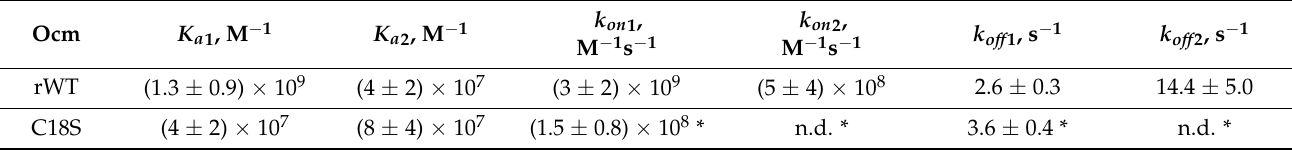
Table 5. Equilibrium and kinetic parameters of Ca 2+ binding to rWT/C18S Ocm at 20 ◦ C, estimated from the fluorimetric experiments. The values of equilibrium metal association constants, K a 1 and K a 2 , and rate constants of metal dissociation, k off 1 and k off 2 , were estimated according to the sequential metal-binding scheme [IV] from equilibrium and stopped-flow experiments shown in Figure 4a,b, respectively. The kinetic constants of Ca 2+ binding to Ocm, k on 1 and k on 2 , were derived from these estimates. Standard deviations for the parameters of Ca 2+ binding to Ocm are